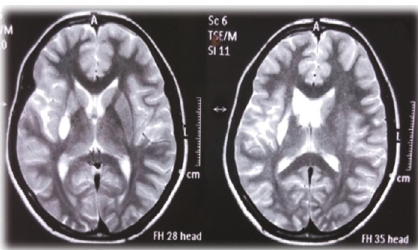
Figure 1: Axial T2-weighted MRI brain image showing infarct in right gangliocapsular region.